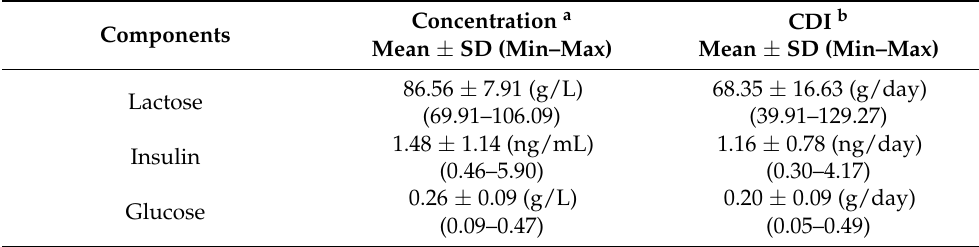
Table 2. Human milk components presented as concentrations and 24-h